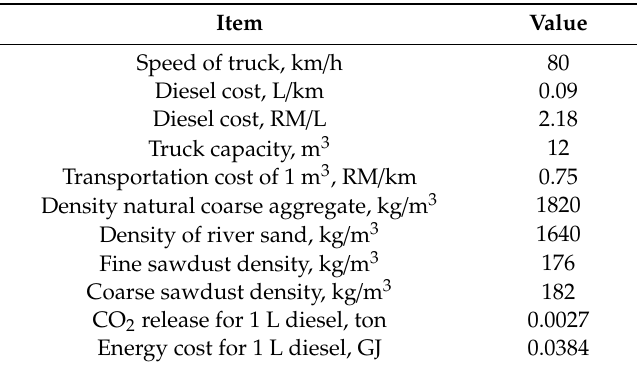
Table 3. Machine and material information for the life cycle calculation.